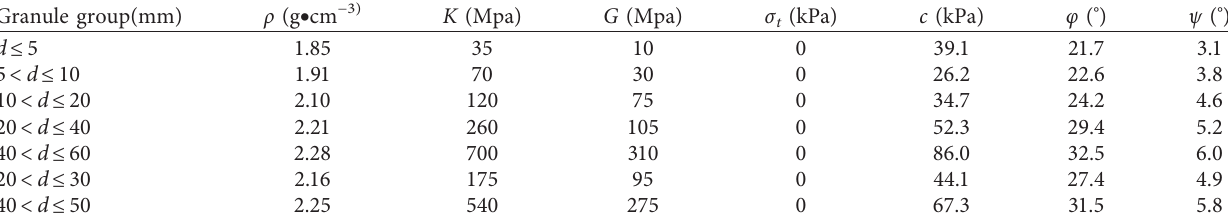
Table 1: The value of the mechanical parameters of each granule group.